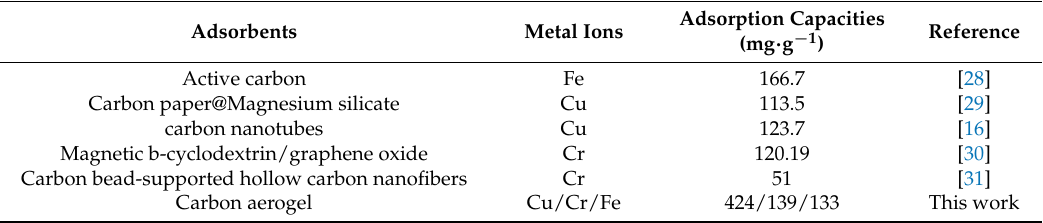
Table 2. Comparative study of different adsorbent for the removal of metal Table 2 . Comparative study of different adsorbent for the removal of metal ions.